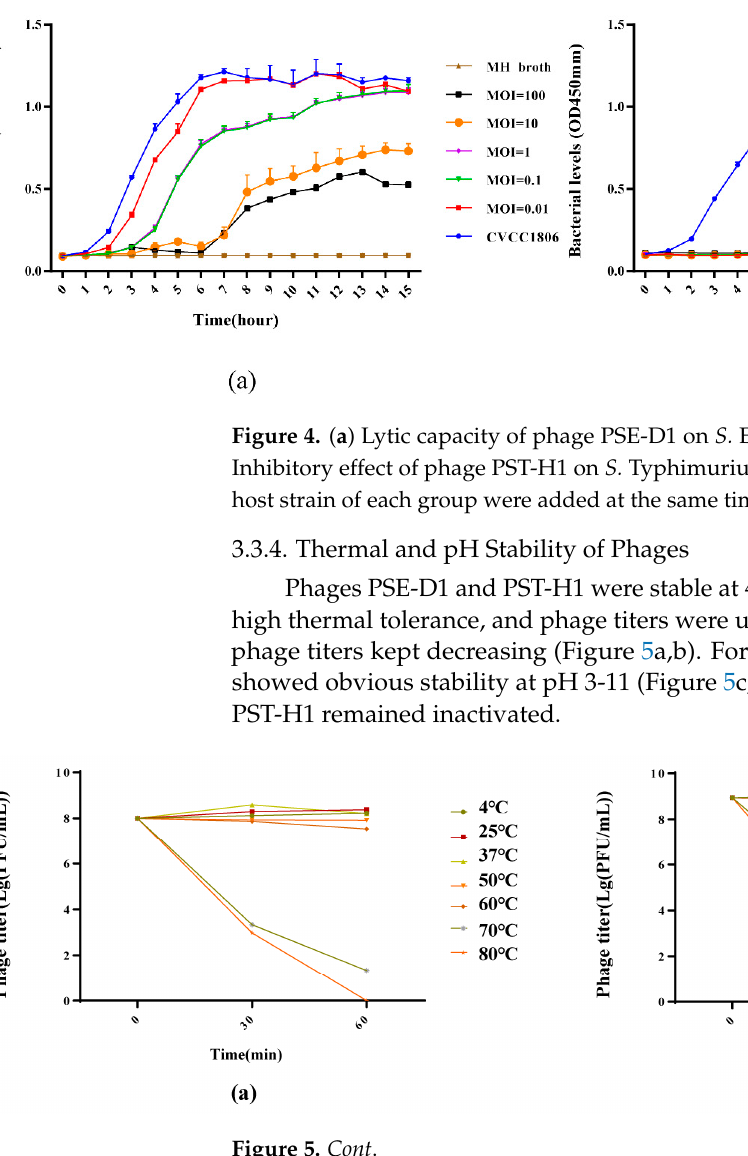
Figure 5. Biological characterization of phages. ( a ) Stability at different pH of PSE-D1. ( b ) Stability at different pH of PST-H1. ( c ) Stability at different temperatures of PSE-D1. ( b ) Stability at different temperatures of PST-H1. 3.4. Genomic Analysis of Phages The Gen Bank accession of PSE-D1 was no. ON550260, and that of PST-H1 was no. ON454038. The two phages were both double-stranded DNA. PSE-D1 had 166,604 bp and the GC content was 39.59% (Figure 6a). PST-H1 consisted of 42,036 bp, and the GC content was 49.95% (Figure 6b). While 115 CDSs had been predicted to encode functional proteins, there were 266 CDSs in the PSE-D1 genome totally. A total of 62 CDSs were associated with DNA replication and regulation; 48 CDSs participated in packing and morphogene- sis proteins; 5 CDSs encoded proteins of host lysis among 115 CDSs (Supplementary Table S1). A total of 61 CDSs were founded in PST-H1 genomes according to protein coding genes prediction, of which 16 CDSs were predicted to encode functional proteins. Among 16 CDSs, 6 CDSs encoded the replication and regulation of DNA, 1 CDS encoded lysis protein, and 9 CDSs encoded packing and morphogenesis proteins (Supplementary Table S2). The plaques of phage PSE-D1and PST-H1 had typical characteristics of lytic bacteri- ophages. Furthermore, gene clusters like Cro, CI, C2, C3, N, and Q were absent from the phage genome, which related to lysogeny, indicating that PSE-D1and PST-H1 were lytic bacteriophages [29]. No known genes associated with virulence and antibiotic-resistance were found in the genome sequence of phages, indicating that PSE-D1 and PST-H1 are safe for use in phage therapy.